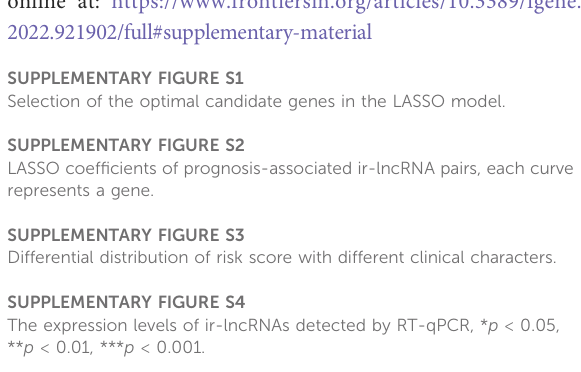
SUPPLEMENTARY FIGURE S1 Selection of the optimal candidate genes in the LASSO model. SUPPLEMENTARY FIGURE S2 LASSO coef fi cients of prognosis-associated ir-lncRNA pairs, each curve represents a gene. SUPPLEMENTARY FIGURE S3 Differential distribution of risk score with different clinical characters. SUPPLEMENTARY FIGURE S4 The expression levels of ir-lncRNAs detected by RT-qPCR, * p < 0.05, ** p < 0.01, *** p <